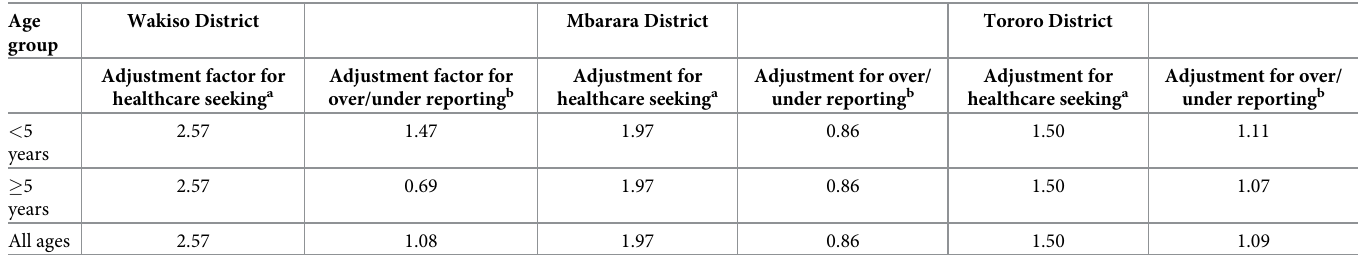
Table 1. Adjustment factors for pneumonia data collected through the Health Management Information System (HMIS) in Uganda, 2013–2016. Age